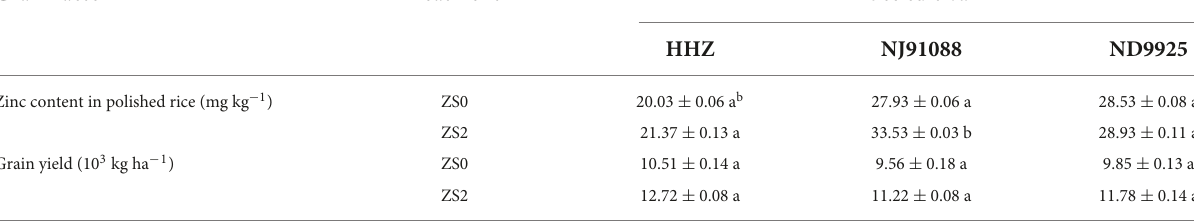
TABLE 2 Zinc content in polished rice and grain yield of three rice cultivars. Grain